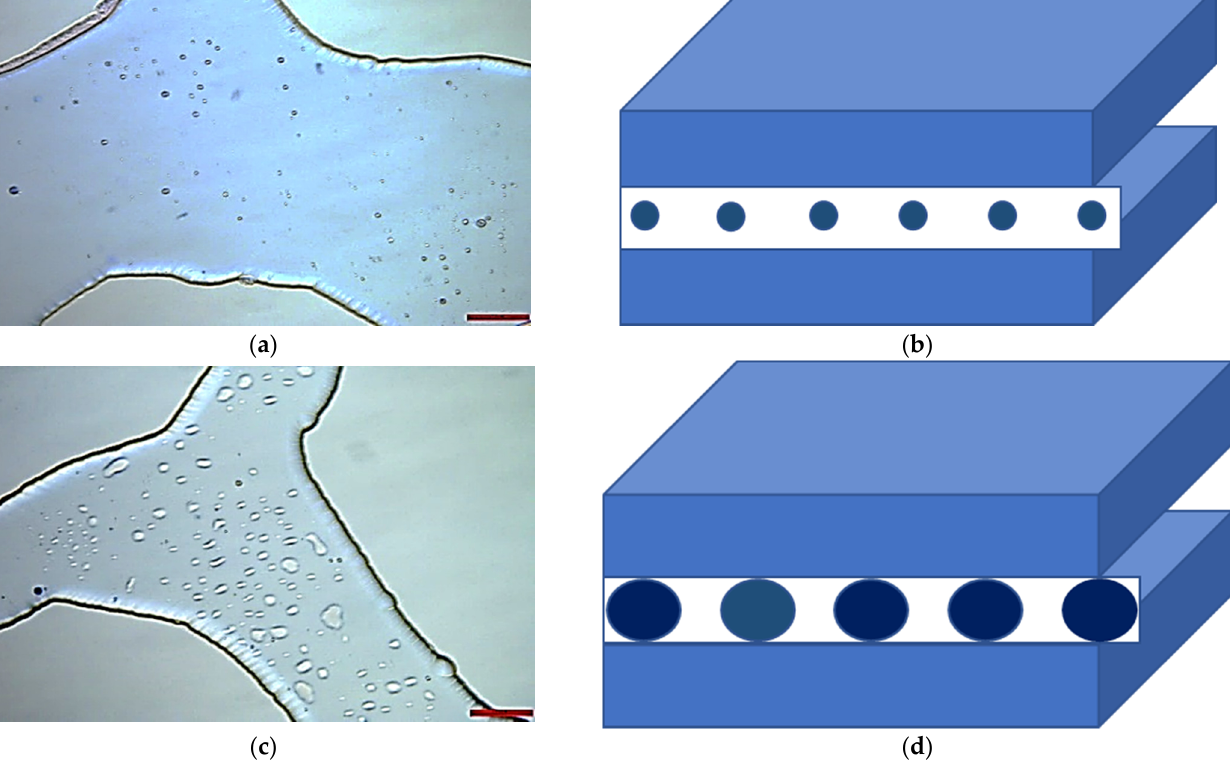
Figure 11. Water shutoff mechanism of polymer microspheres. ( a ) The distribution of polymer microspheres in the channel before expansion; ( b ) no permeability loss before expansion; ( c ) the distribution of polymer microspheres in the channel after expansion; ( d ) permeability loss caused by blocked pores after the expansion of polymer microspheres.